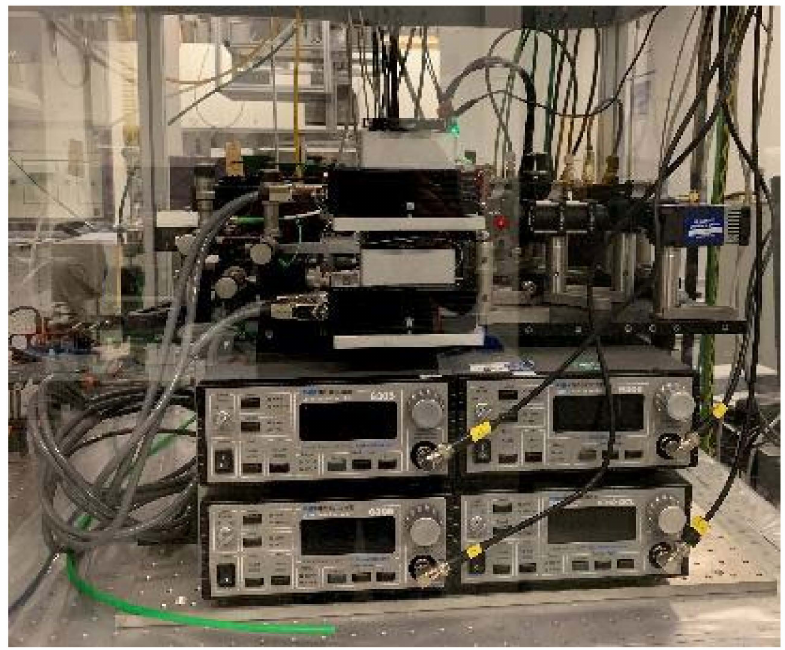
Figure 5. Side view of the sending unit mounted on an optical breadboard with the laser controllers